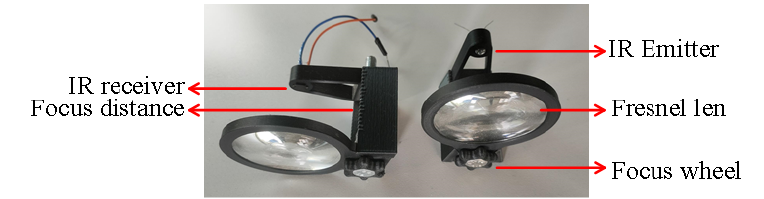
Figure 9. Optical sensor infrastructure.